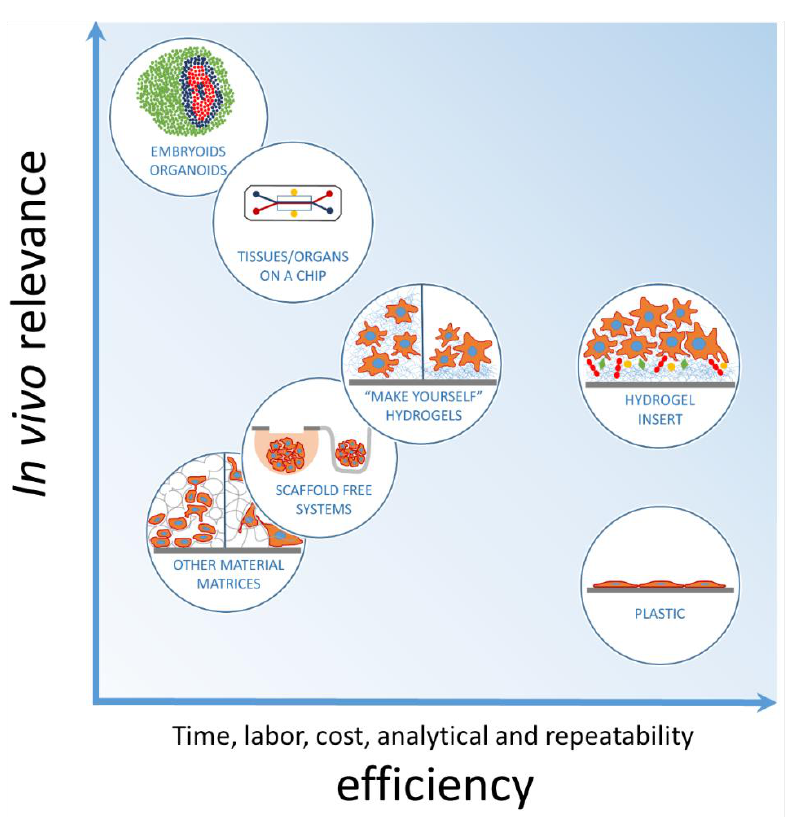
Figure 9. Arbitrary comparison of the common in vitro systems: tissue relevance vs. practical handling and functionality.